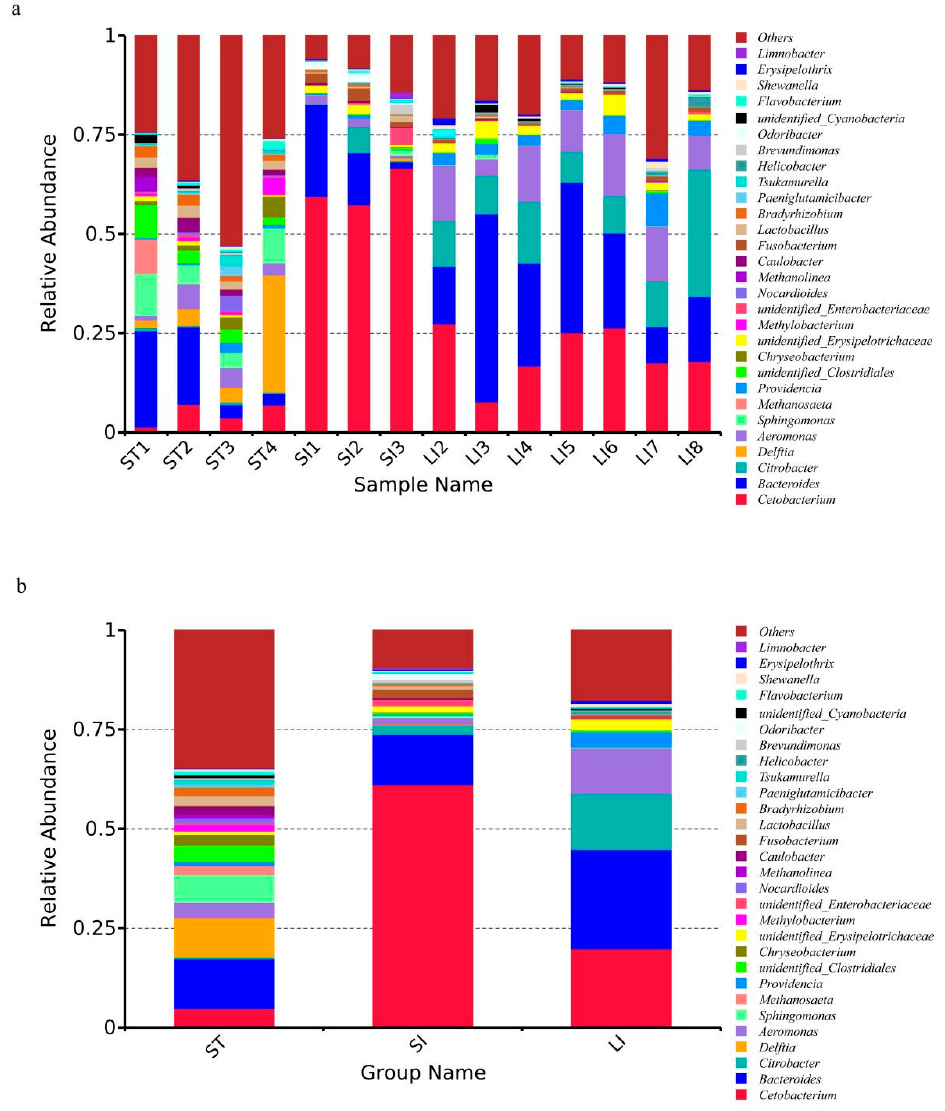
Figure 4. Microbial composition of different samples ( a ) and segments ( b ) at the genus level. The top 30 most abundant taxa are shown. Abbreviations: LI, large intestine; SI, small intestine; ST, stomach.